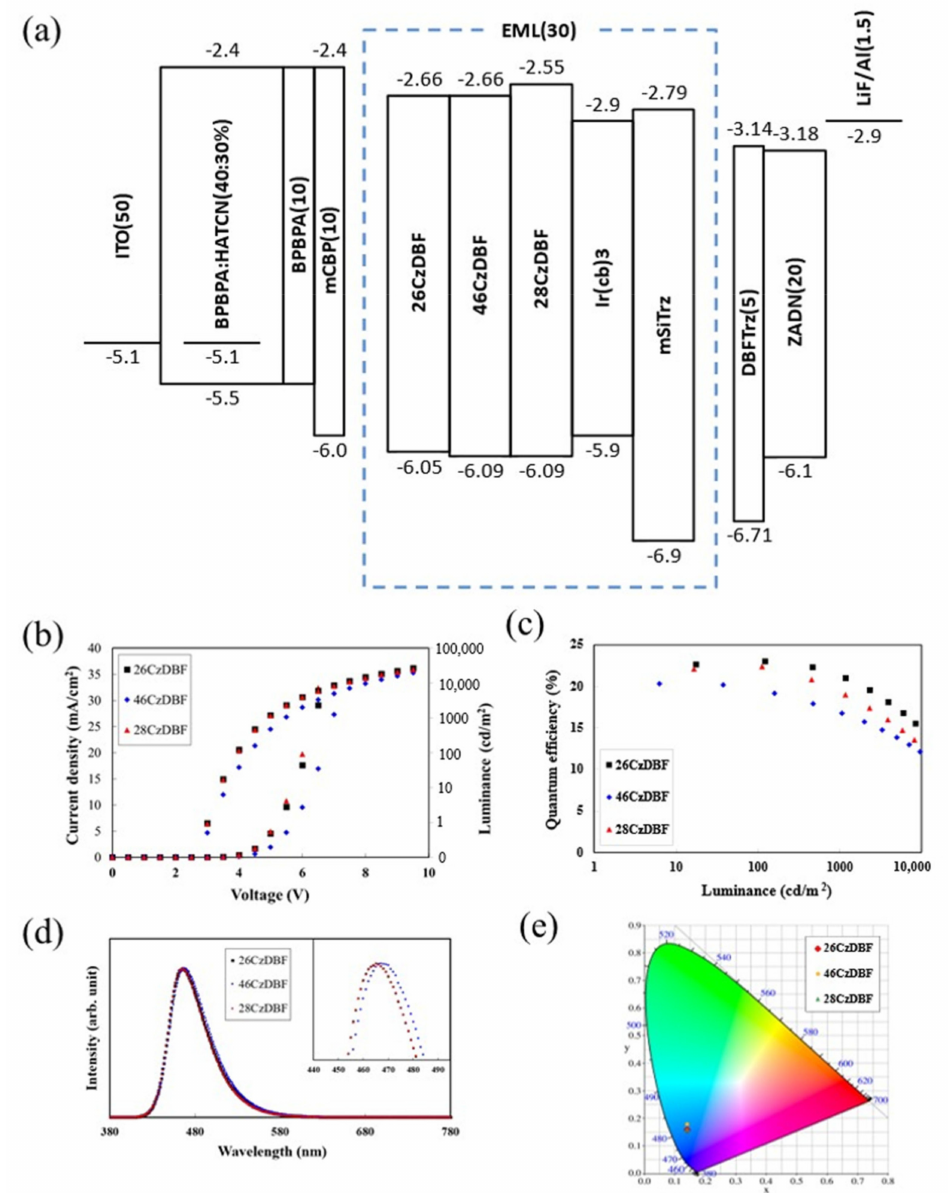
Figure 3. ( a ) Device structure, ( b ) Current density-voltage-luminance, ( c ) EQE-luminance, ( d ) EL spectra (inset: enlarged spectra), and ( e ) color coordinate of the 26CzDBF:mSiTrz, 46CzDBF:mSiTrz, and 28CzDBF:mSiTrz deep blue